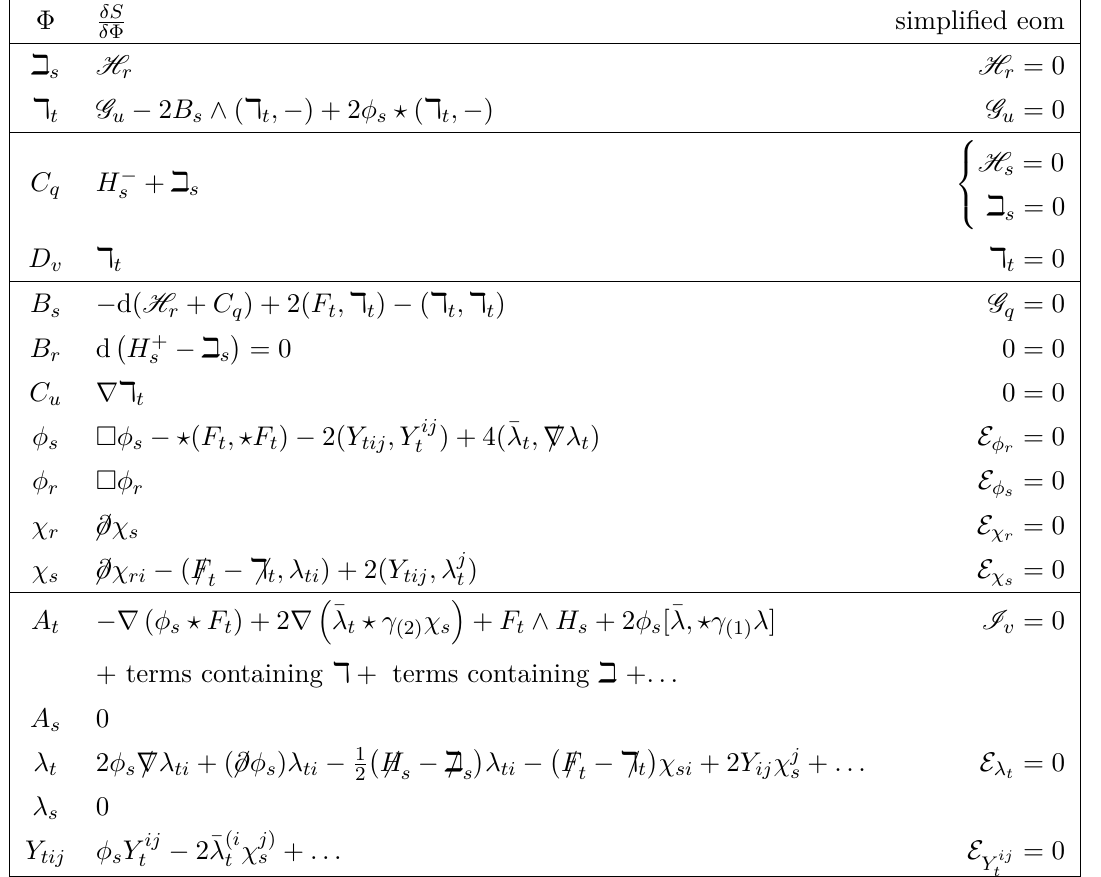
are defined in (3.25). Ellipses Y ij